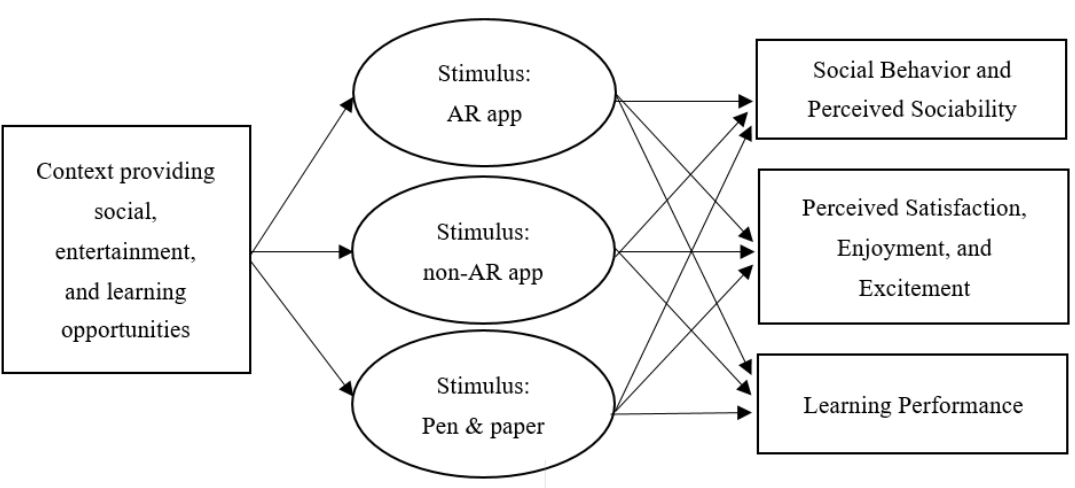
Figure 1. The study design.